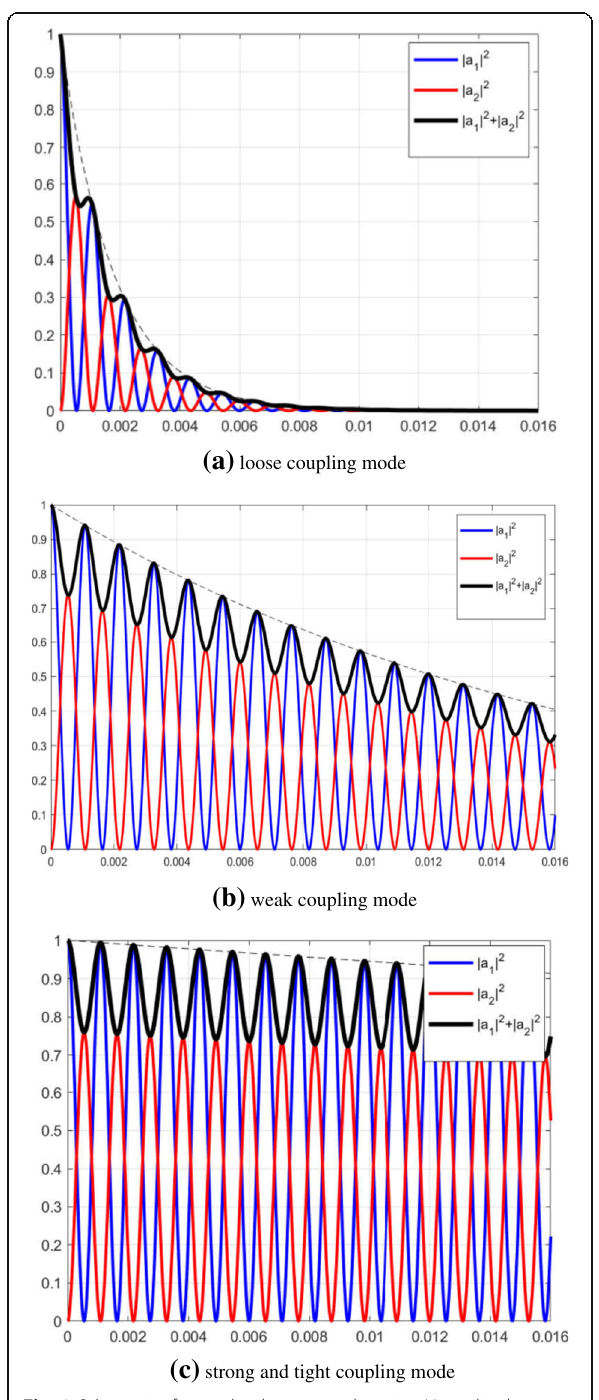
Fig. 3 Schematic of normalized energy exchanging. Normalized energy exchanging is solved by coupled mode method. In loose coupling mode, the power of the system quickly attenuates to zero. In weak coupling mode, the rate of energy exchange between the transmitter and the receiving end is very small; it means that the transmitting efficiency is low. In strong and tight coupling mode, the system will work in a highly efficient transmission and low-loss state. a Loose coupling mode. b Weak coupling mode. c Strong and tight coupling mode